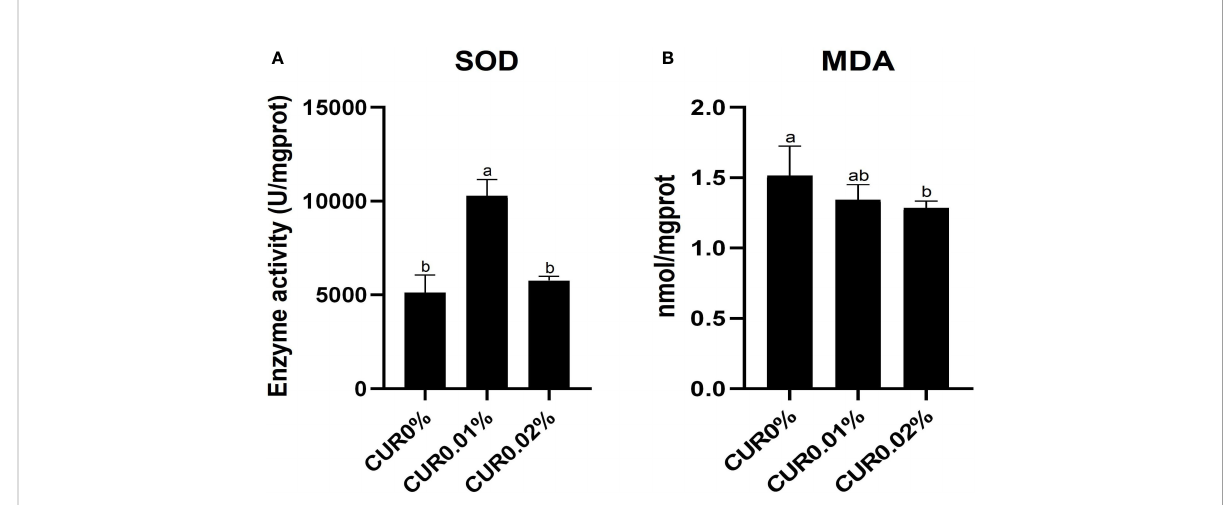
FIGURE 3 The activity of SOD (A) and the concentration of MDA (B) in liver of the greater amberjack after the 8-week feeding in Experiment I. Different letters above bars indicate signi fi cant differences at the 0.05 level. Data are expressed as the means ± SD